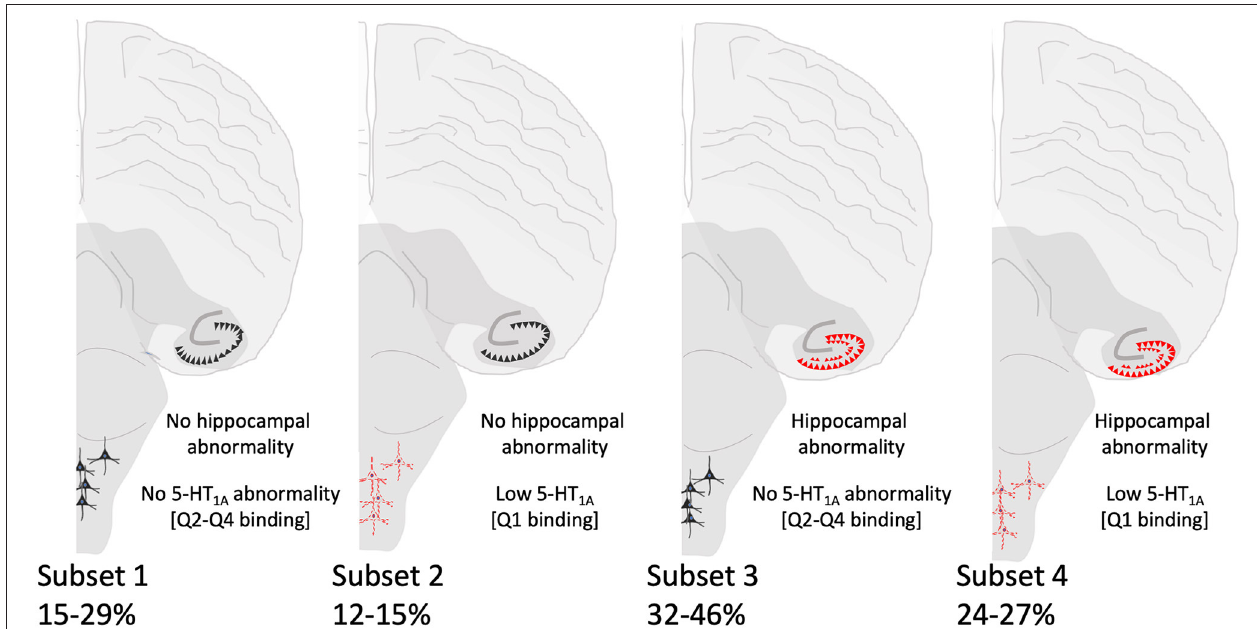
FIGURE 4 | Summary of SIDS subsets based on hippocampal and brainstem (5-HT 1A ) abnormalities. Hippocampal morphological and brainstem 5-HT 1A abnormalities are depicted in red. The percentages of SIDS cases falling within each subset are shown and vary depending on the hippocampal feature.